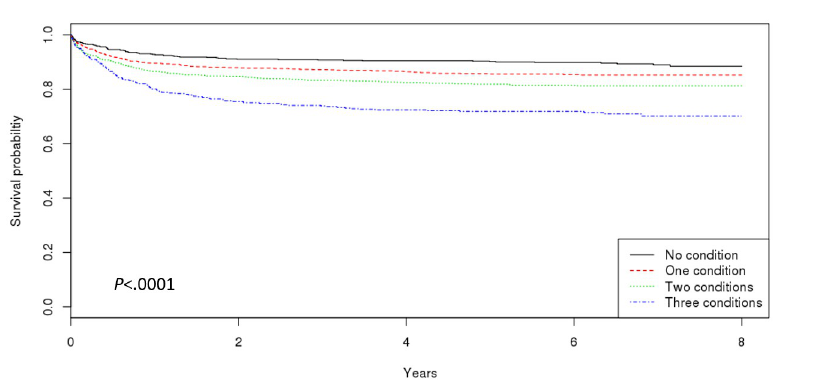
Fig 3. Survival curves by the number of metabolic comorbidities on MALE.